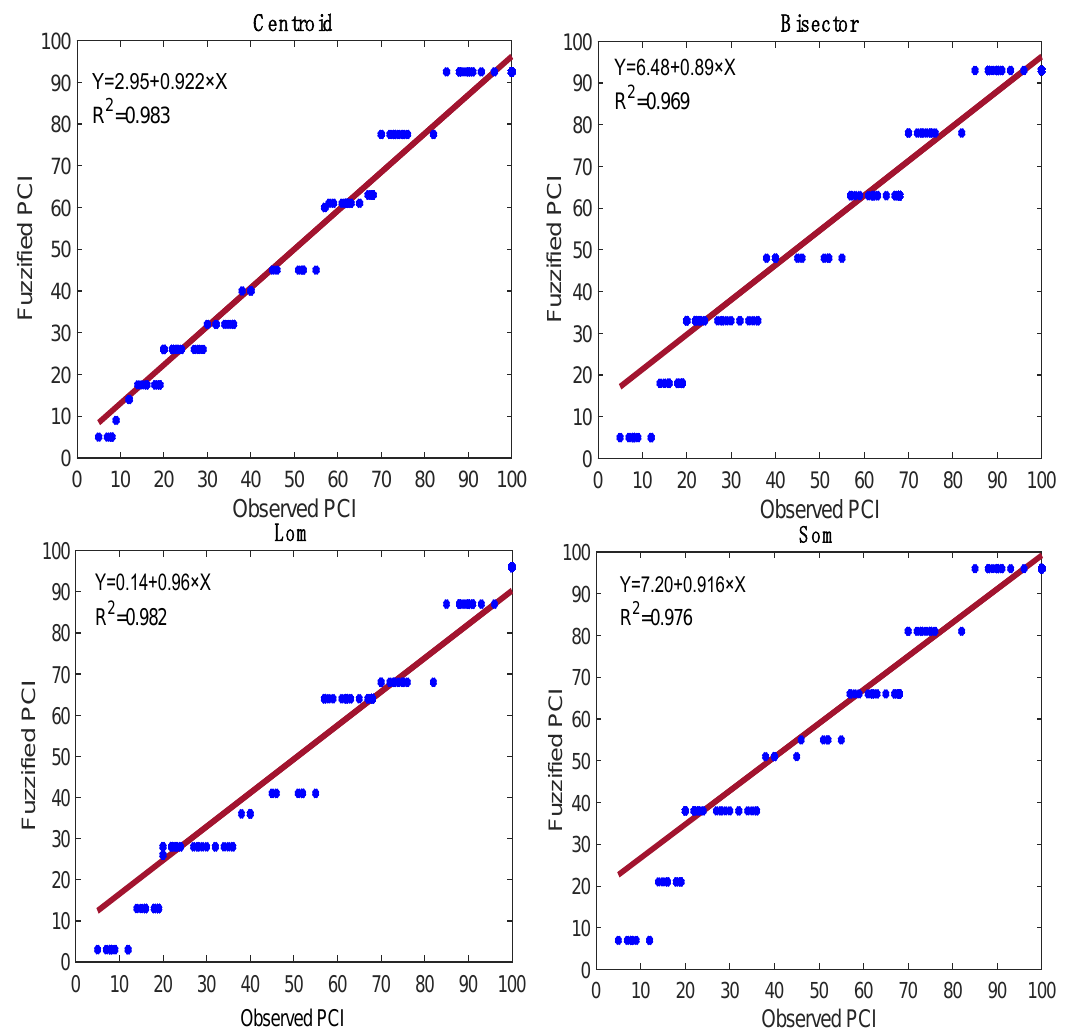
Figure 5. Performance of a fuzzy inference system-based PCI for 150 sections.